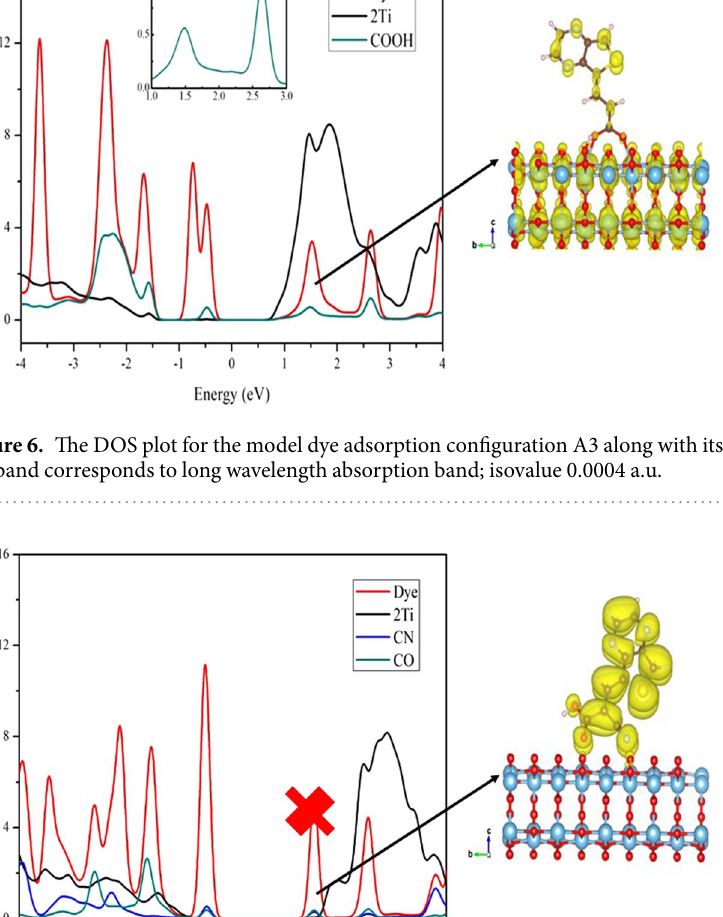
group in the anchoring part does not improve the electron injection ability, even it directly binds to the surface. To better account for the role of cyano group on the electron injection ability, we plotted PDOS for the different decomposed partial charge density for A3, and B4 configurations are presented in Figs 6 and 7, respectively. The same for remaining configurations (A2, B2, B3 & B5) are given in Figures S3–S6 of supporting information, respectively. Figure 6, S3–S5 clearly show that the electrons are localized in acceptor and anchoring moieties for A2, A3, B2, and B3 configurations. However, the presence of cyano group in B2, B3, and most stable B5 configu- rations decreases the peak intensity of COOH (inset of Figures S4, S5 and S6), which might be due to the strong withdrawing ability of cyano group than COOH. Further, we found that the peak corresponds to long wavelength absorption band for B4 is not overlapped with surface Ti atoms (see Fig. 7). Thus electron injection through this configuration is comparatively less even though the electrons are located in the anchoring group moiety. The above results show that the presence of cyano group in the anchoring group decreases the electron injection abil- ity when it does not involve in the binding with surface atoms. On the other hand, configurations in which cyano group binds with surface atoms along with carboxyl group did not improve the electron injection ability. Hence,